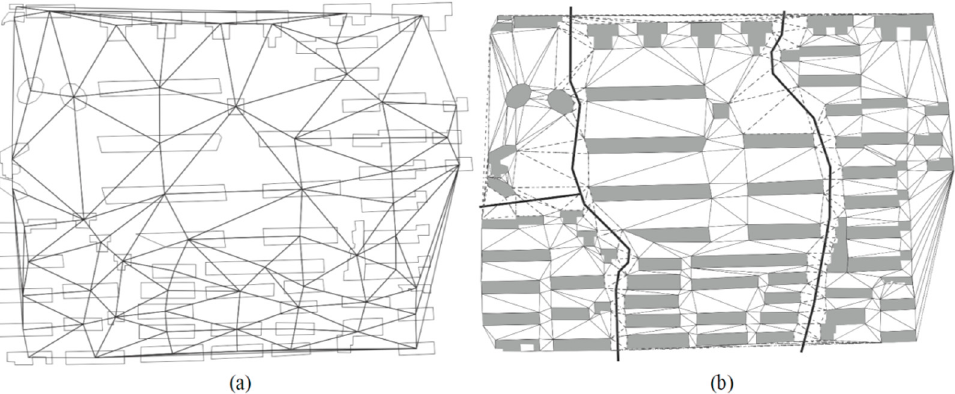
Figure 3. Delaunay triangulation: ( a ) non-constraint; ( b ) boundary constraint.